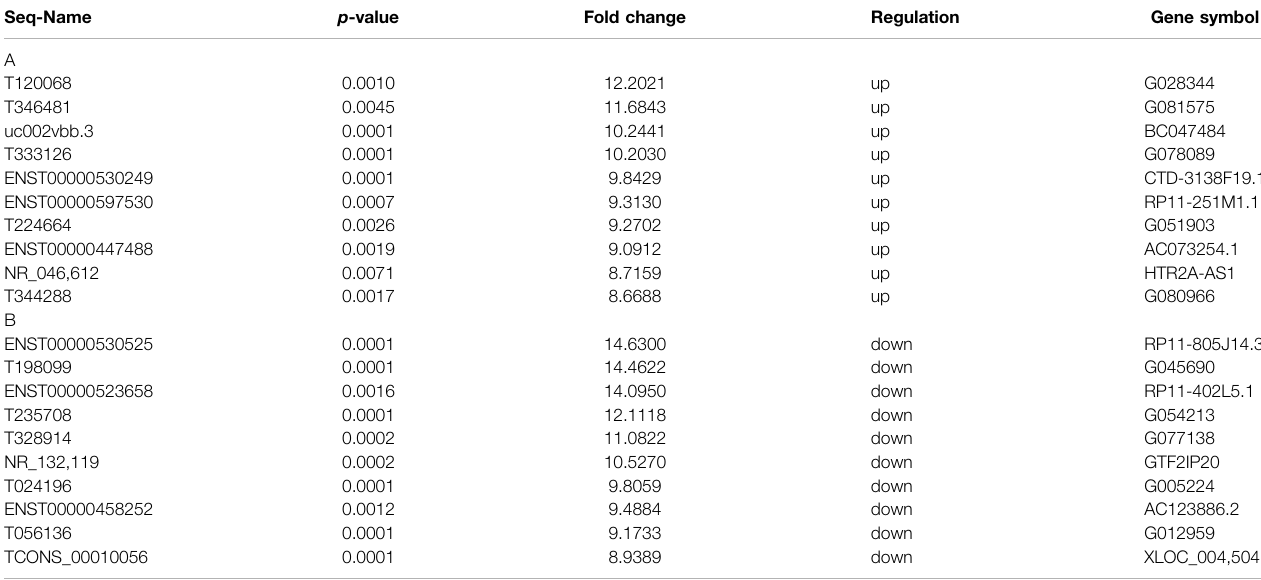
TABLE 2 | The top 10 highly up- and downregulated